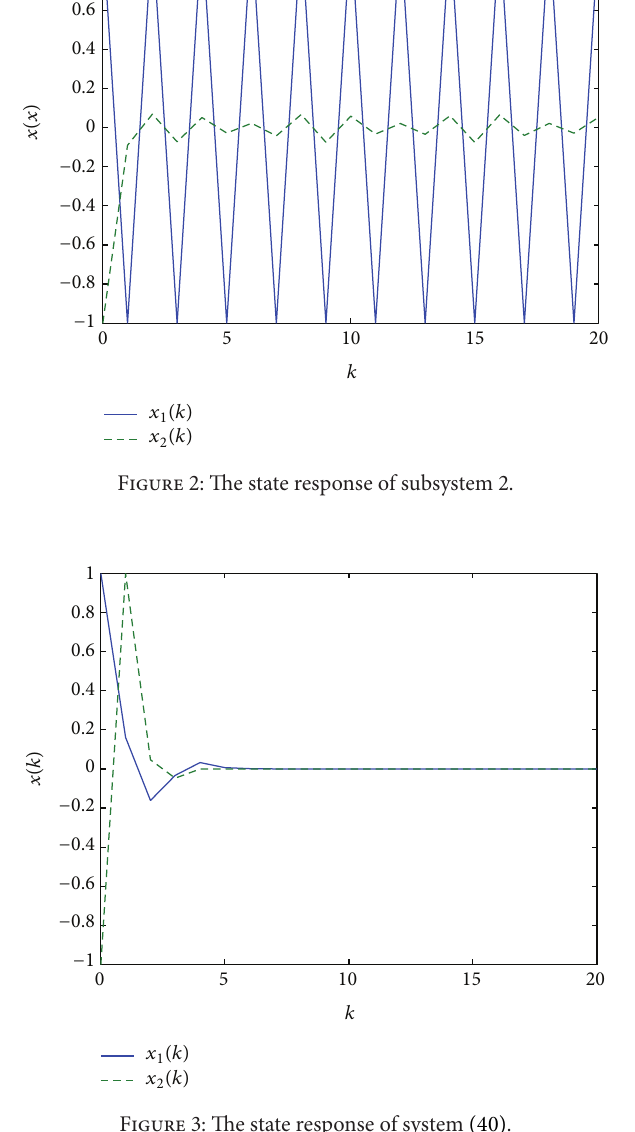
Figure 3: The state response of system (40).